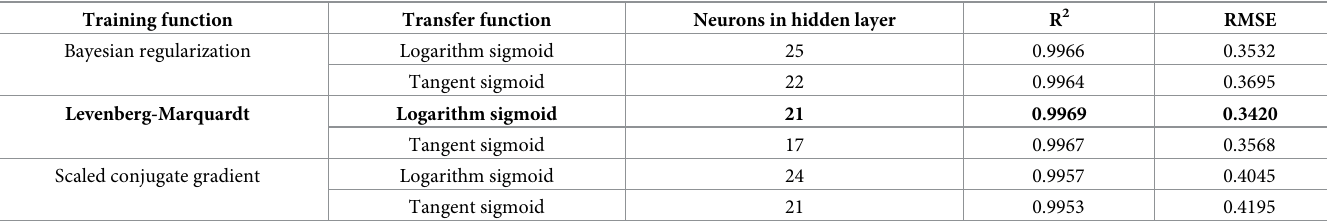
Table 6. The most accurate ANN models trained with 2019 data for estimation of LA based on leaf length and width. Training